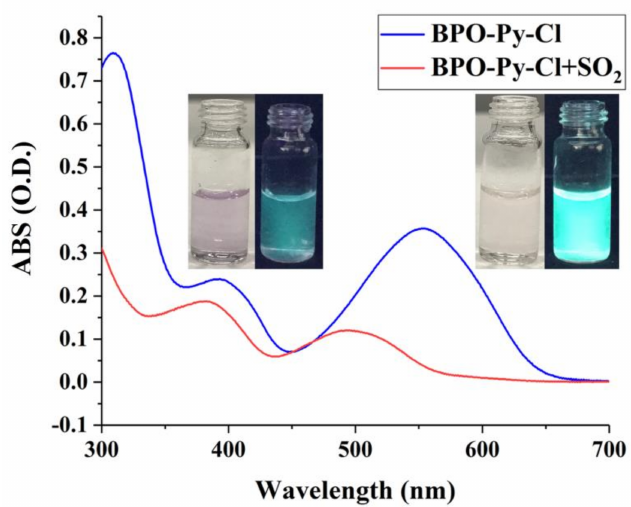
Figure 1. The absorption spectra and colorimetric changes of BPO-Py-Cl (10 µ M) interacting with SO 2 (500 µ M) under visible and 365 nm ultraviolet lamps.